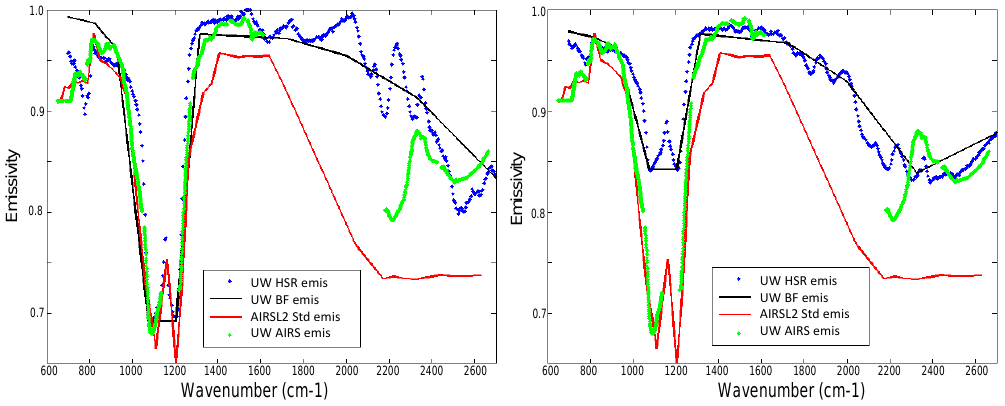
Figure 2. Emissivity comparison on January 2003 over Sahara Desert (Lat = 25.075N, Lon = 26.058E) of UW BF (solid black line), UW high spectral resolution (HSR) (blue dots), the AIRS L2 (V5.0) Standard products (red line), and the UW/AIRS (green dots) emissivity products. ( Left ) The UW BF and UW HSR emissivity products have been derived from the Col 4, and ( Right ) from the Col 5 MODIS emissivity products.